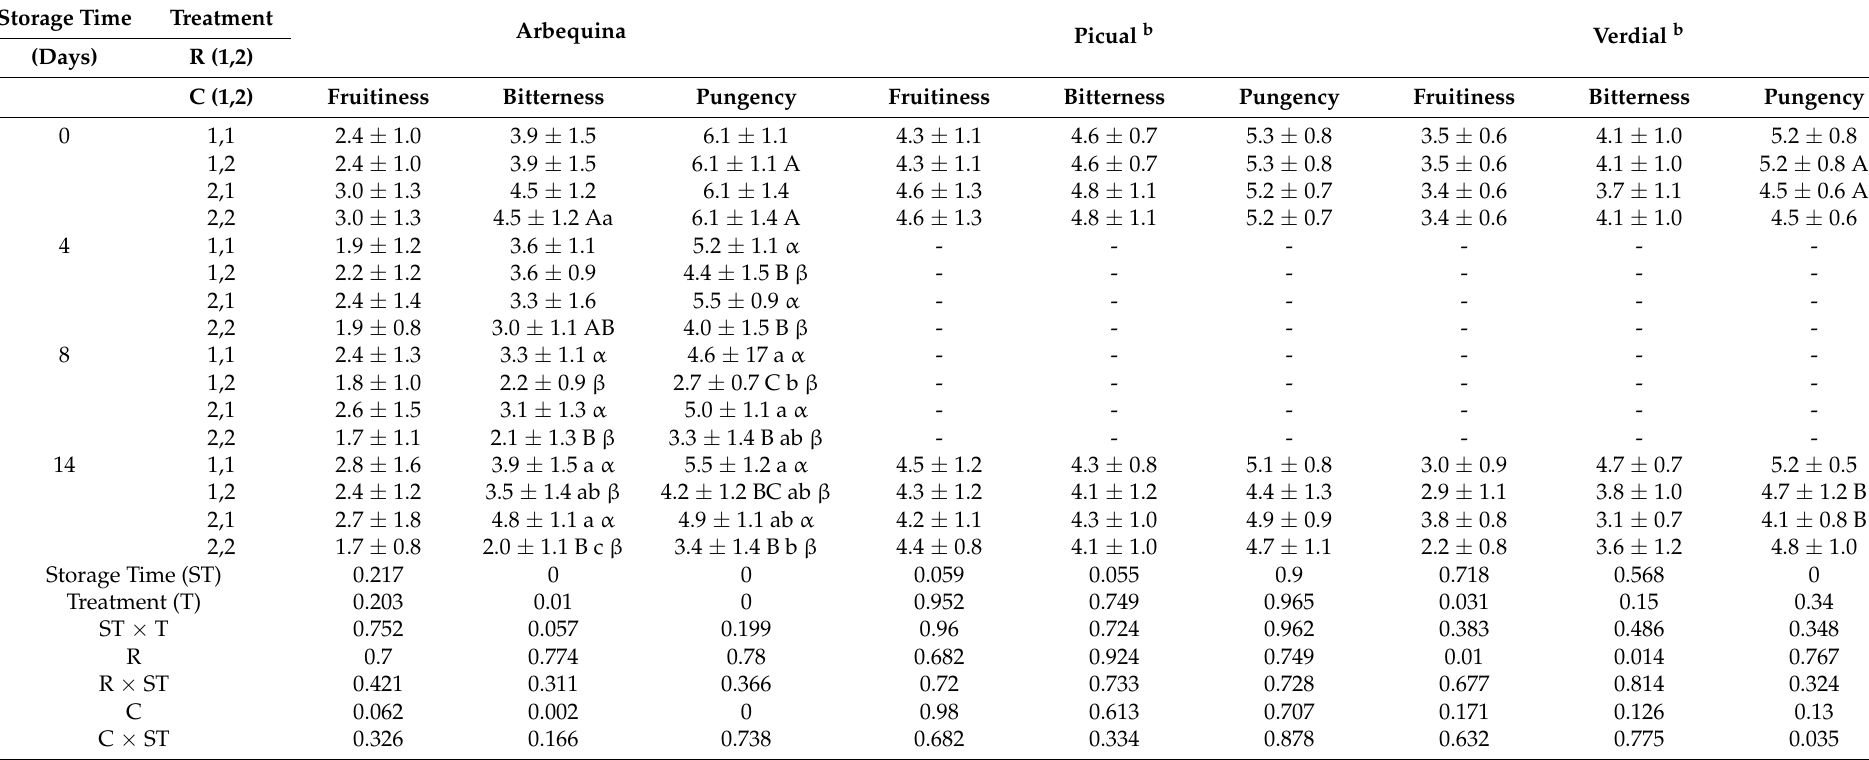
Table 2. Intensity of three positive attributes (Fruitiness, Bitterness, and Pungency) as noted by a sensory analysis panel in the ‘Arbequina’, ‘Picual’, and ‘Verdial’ olive oils extracted from fruit, picked with a Manual Inverted Umbrella (R1) and in a traditional way (R2) and stored for 0, 4, 8, and 14 days at 5 ◦ C (C1) and at ambient temperature (C2). The panel was formed by 8 approved